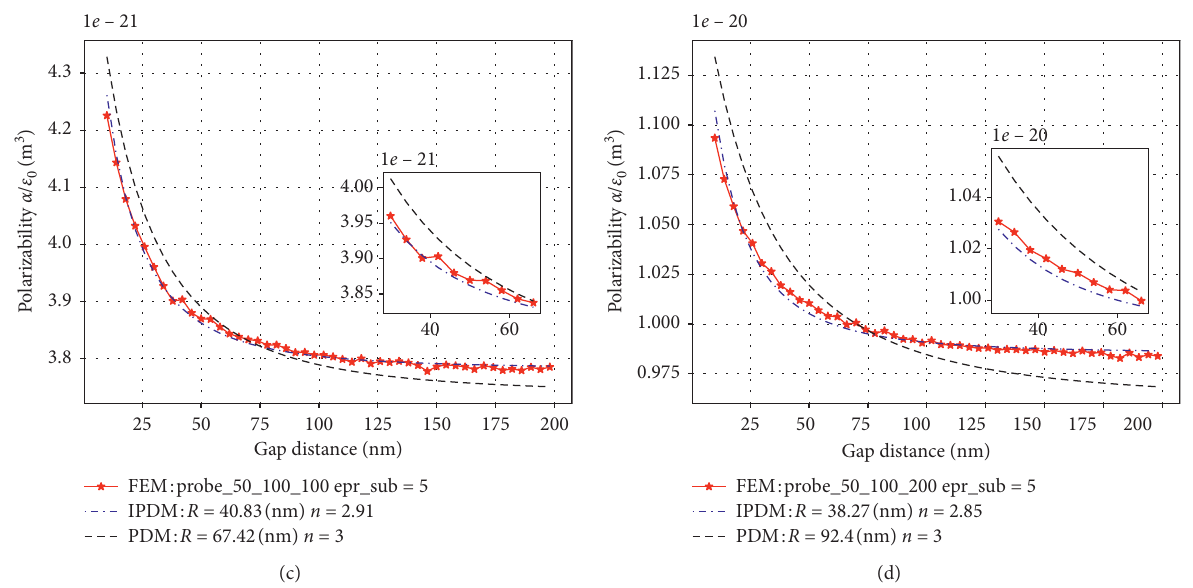
Figure 6: (a) The probe-approaching curve for case 3. The cone dielectric probe has a dielectric constant of 100; the cone bottom radius R 1 is 50nm, top radius R 2 is 100nm, and cone length is d � 100nm; an equivalent spherical radius is R � 58.84nm; n � 2.98. (b) The probe- approaching curve for case 4. The cone dielectric probe has a dielectric constant of 100; the cone bottom radius is 50nm, top radius is 100nm, and cone length is 200nm; the equivalent spherical radius is R � 63.54nm; n � 2.89. (c) The probe approaching curve for case 5. The cone dielectric probe has a dielectric constant of 100, the cone bottom radius R 1 is 50nm, top radius R 2 is 100nm, and cone length is d � 100nm; the equivalent spherical radius is R � 40.83nm; n � 2.91. (d) The probe-approaching curve for case 6. The cone dielectric probe has a dielectric constant of 100, the cone bottom radius R 1 is 50nm, top radius R 2 is 100nm, and cone length is d � 200nm; the equivalent spherical radius is R � 38.27nm; n �